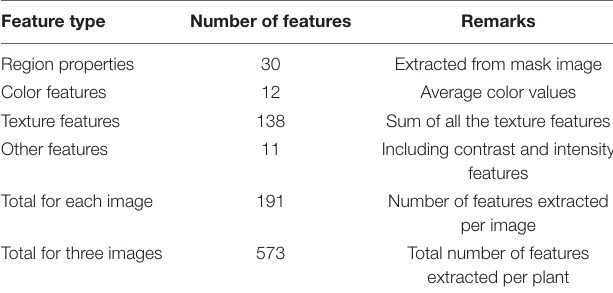
TABLE 3 | Region properties used for shape-based feature extraction. TABLE 4 | Total number of features extracted for each watermelon